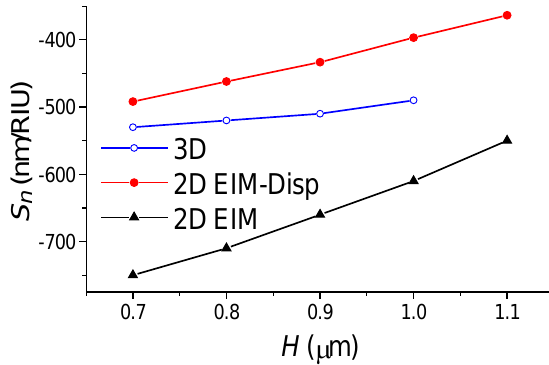
Figure 5. The dependence of the slope change S n = ∂ λ/∂n on the index of surrounding medium (water). Calculation by finite difference time domain (FDTD) method for 3D and 2D cases. 2D modeling is accomplished using the standard EIM and the dispersion compensation algorithm (EIM-Disp).